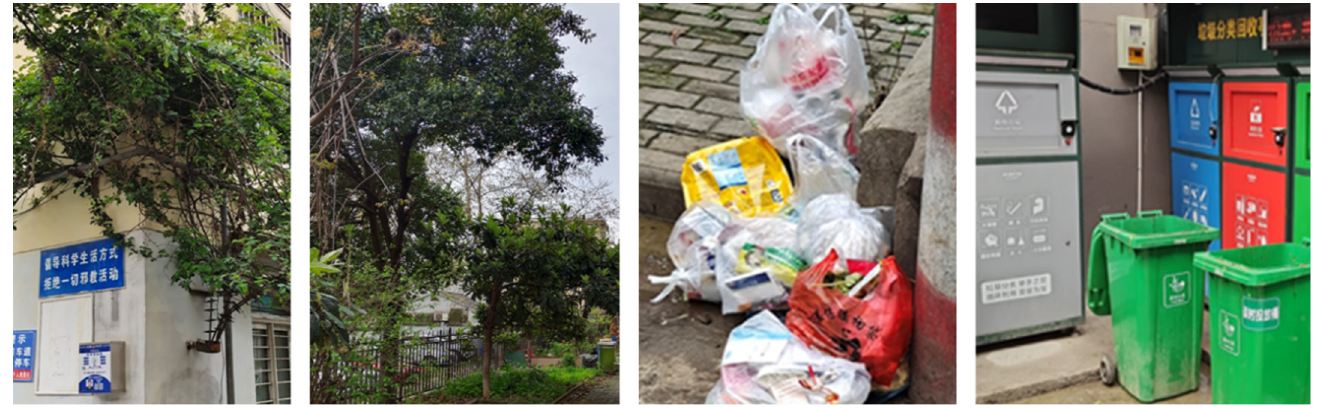
Figure 9. District environment (photographed by Yuxin Xu in 2022).